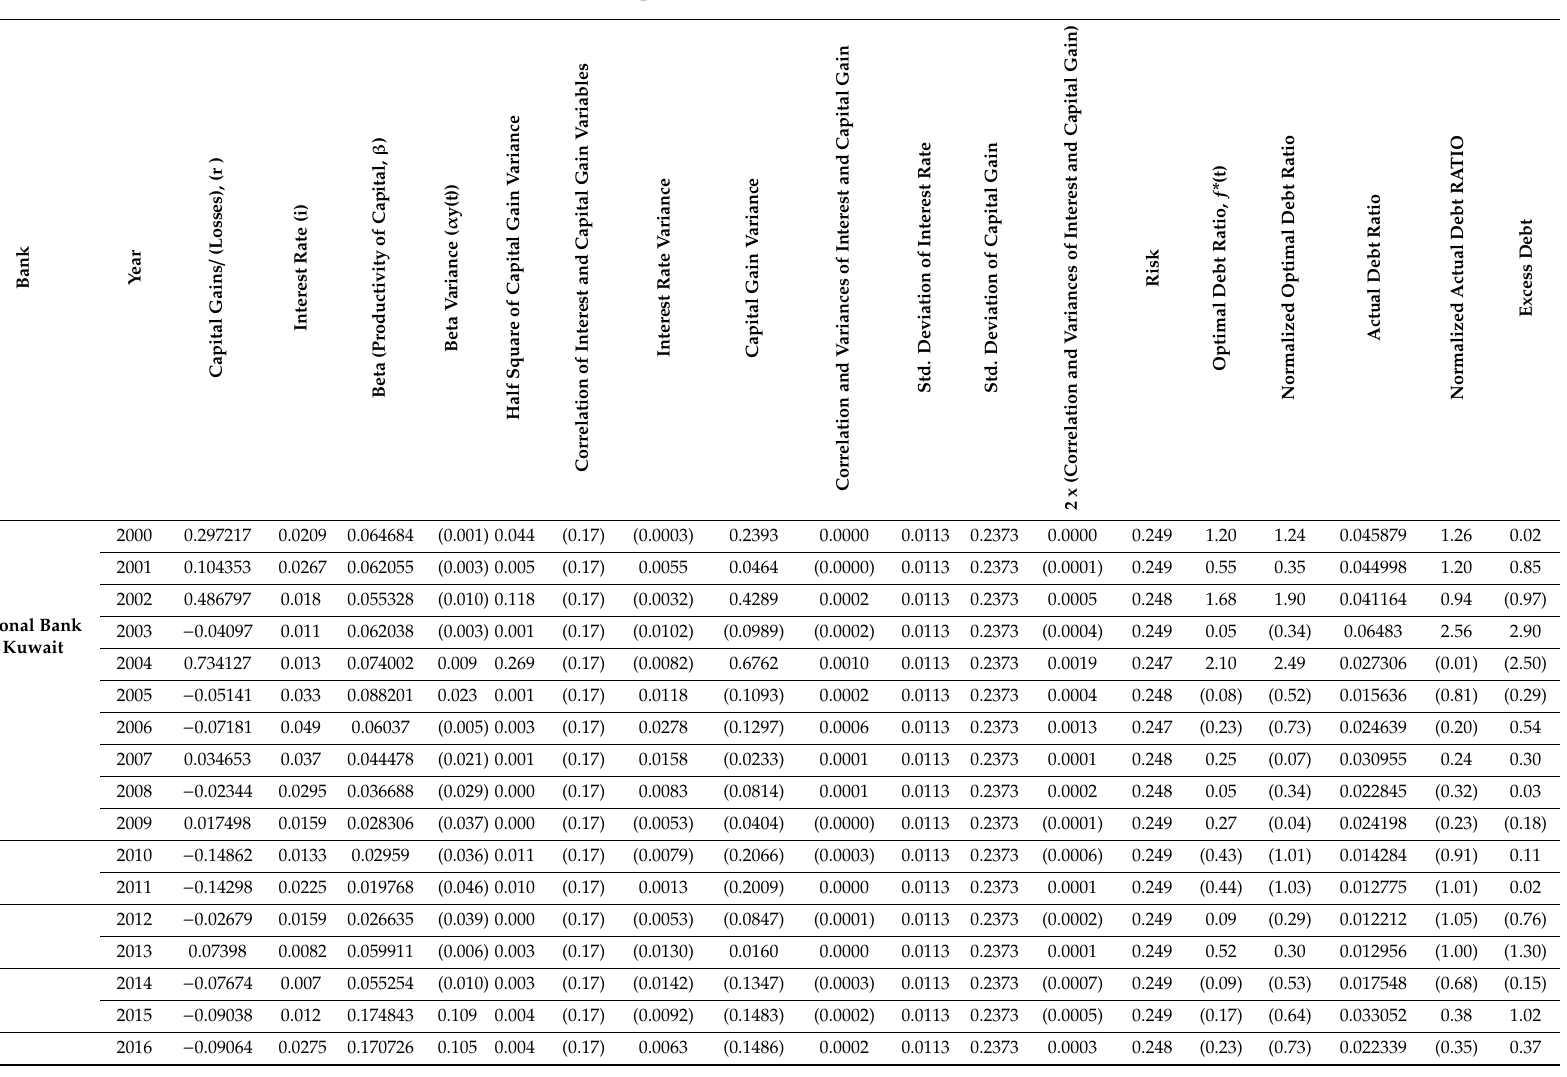
Table A6. Calculations of Optimal and Excess Debt: National Bank of